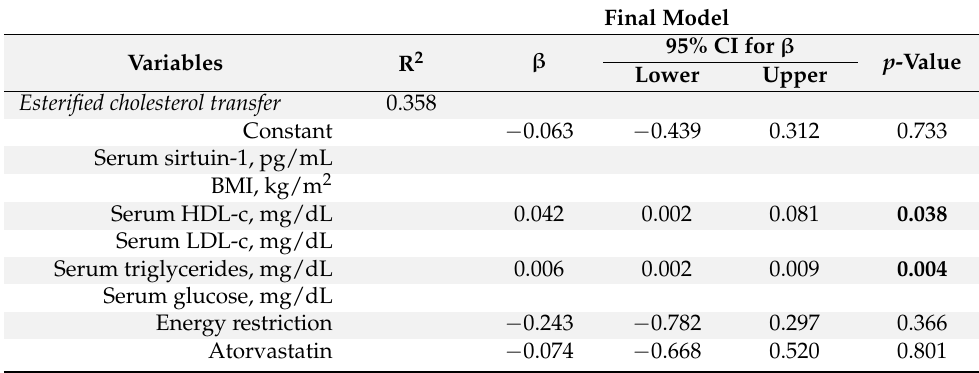
Table 3. HDL particle’s lipid composition and cholesterol